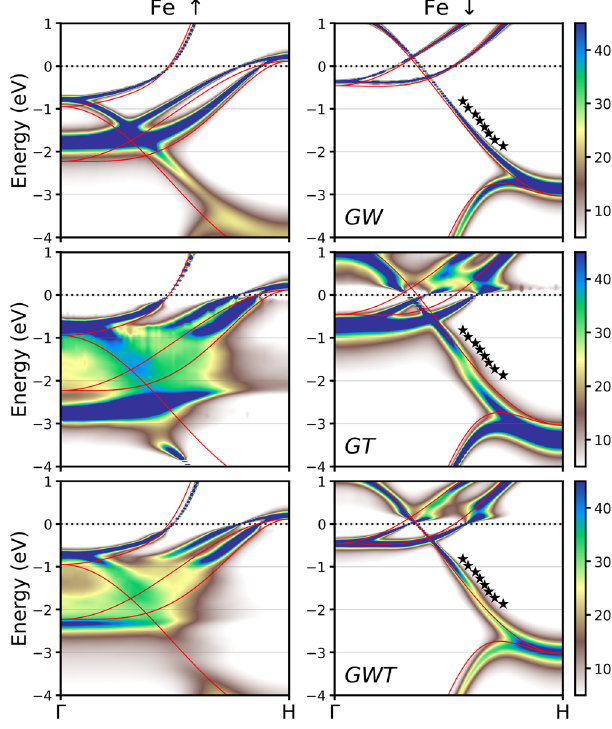
Fig. 4 Renormalized band structures of bcc Fe for Γ – H. Majority and minority band structures of bcc Fe renormalized with GW , GT , and GWT self-energies along Γ – H. Quasiparticle energies extracted from the ARPES spin-down spectrum in the vicinity of the electron – magnon kink 7 are shown by black